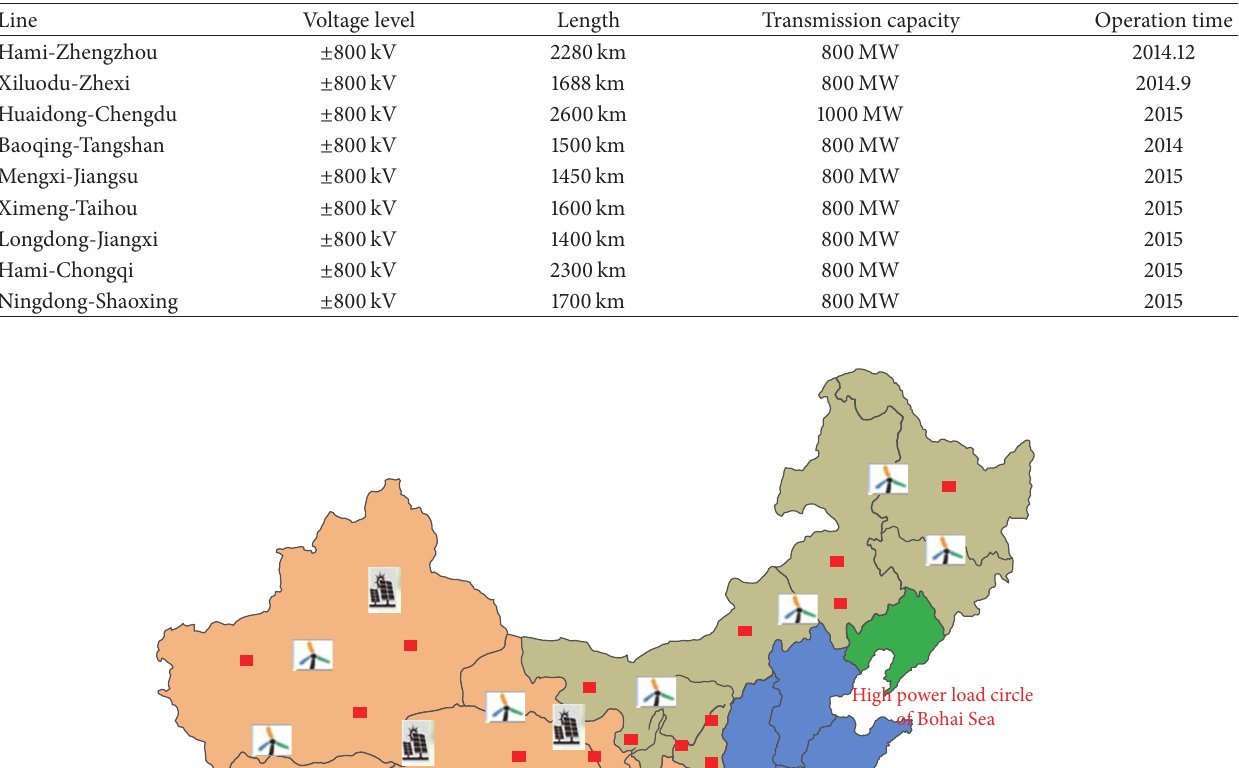
Table 1: The extra-high voltage planning projects of State Grid of China.